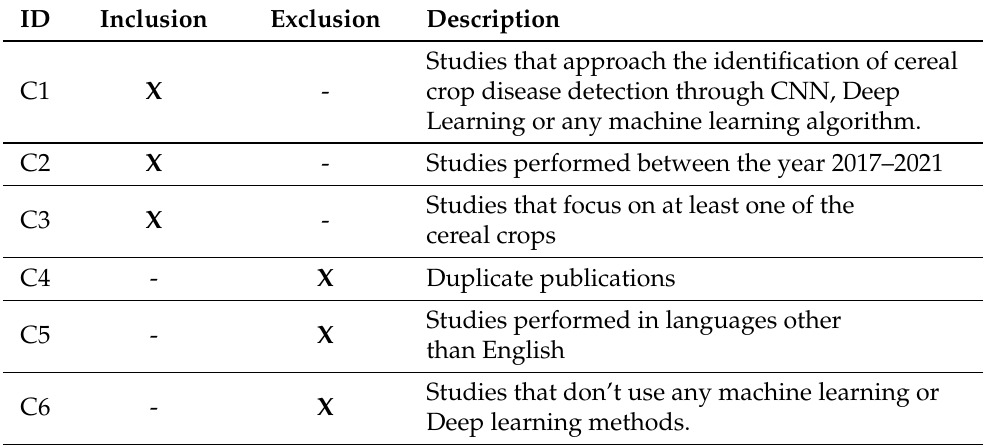
Table 9. Selection criteria.